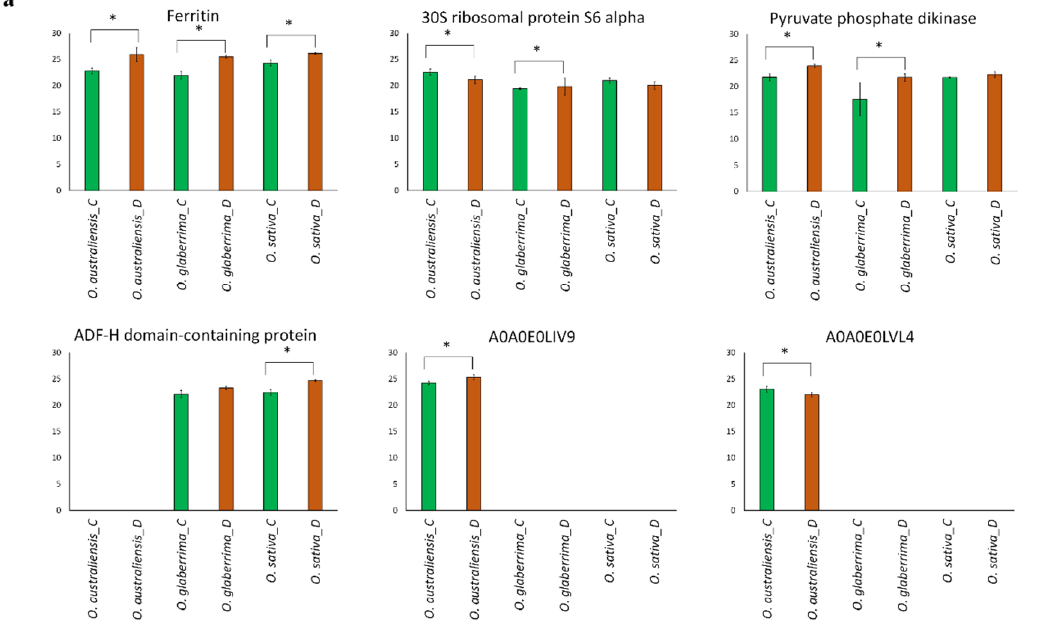
Figure 6. Parallel Reaction Monitoring (PRM) validation of drought stress-responsive proteins. ( a ) Bars illustrate the relative abundance of proteins (Log 2 area) in three rice species under control (C) and drought stress (D) conditions. An asterisk (*) indicates a statistically significant difference between the control and drought conditions, according to a Mann–Whitney U-test ( p -values < 0.05). ( b ) PRM transitions used for targeted verification of AAGDGDGGFSFGGLFSK.